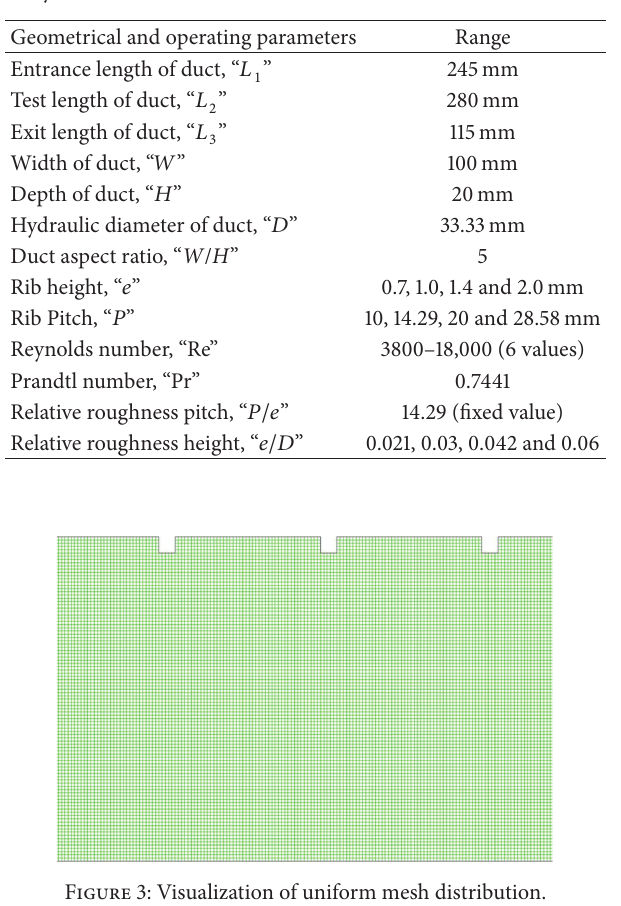
Table 2: Range of geometrical and operating parameters for CFD analysis.